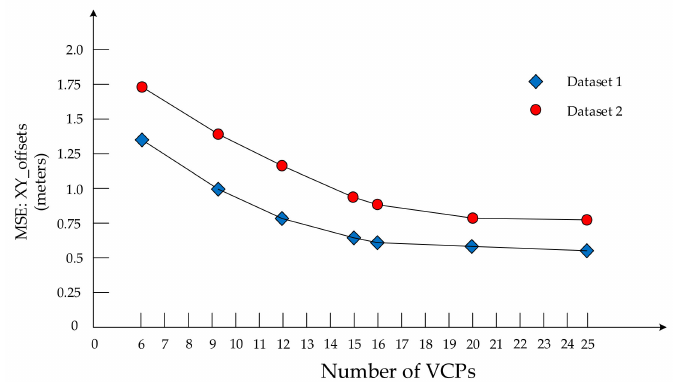
Figure 14. The influence of the number of